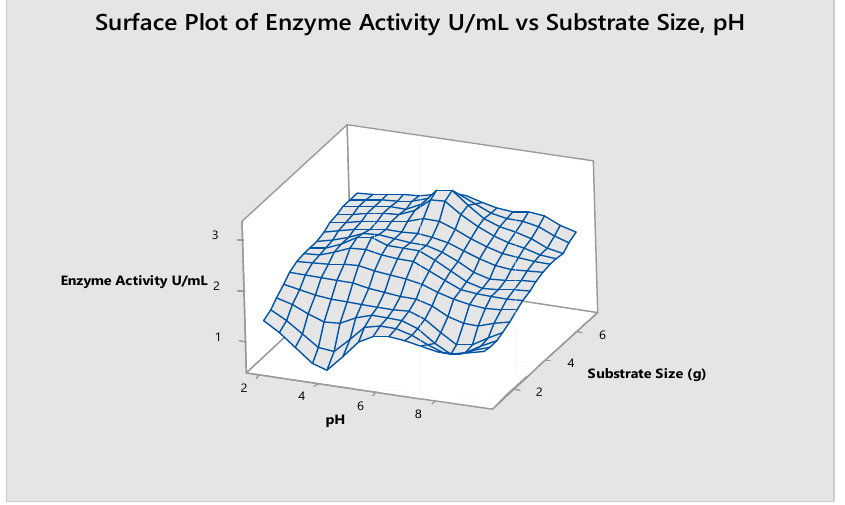
Figure 3. Surface plot of Enzyme Activity (U/mL) vs. Substrate Size and pH.